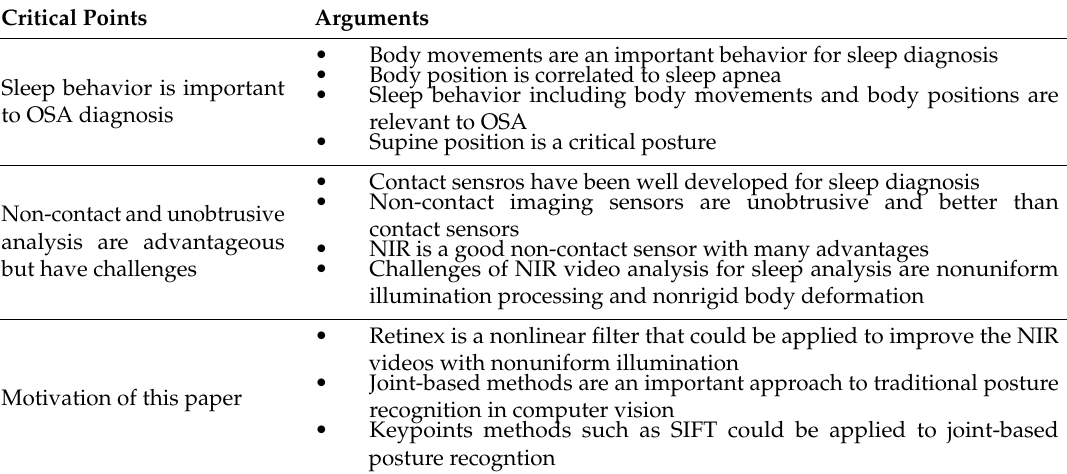
Table 1. Summary of reviews from related